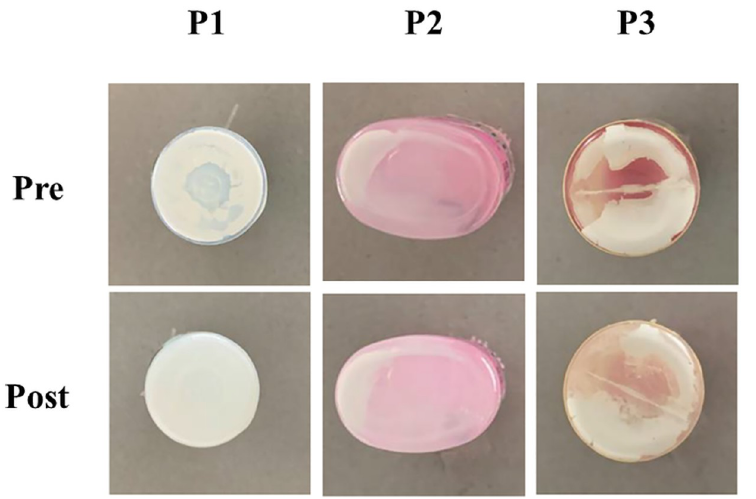
Fig 2. Changes in the deposition of 0.1% FLU ophthalmic suspensions attached to the underside of each container before and after agitation with hands. All the formulations of 0.1% FLU ophthalmic suspensions were stored at 10 ˚C for three months and subsequently maintained at room temperature for two months. Optical images for the deposition of FLU ophthalmic suspensions attached to the underside of each container before and after agitation with hands are shown. P1; Original, P2; Generic A, P3; Generic B. All the images are representative of three independent